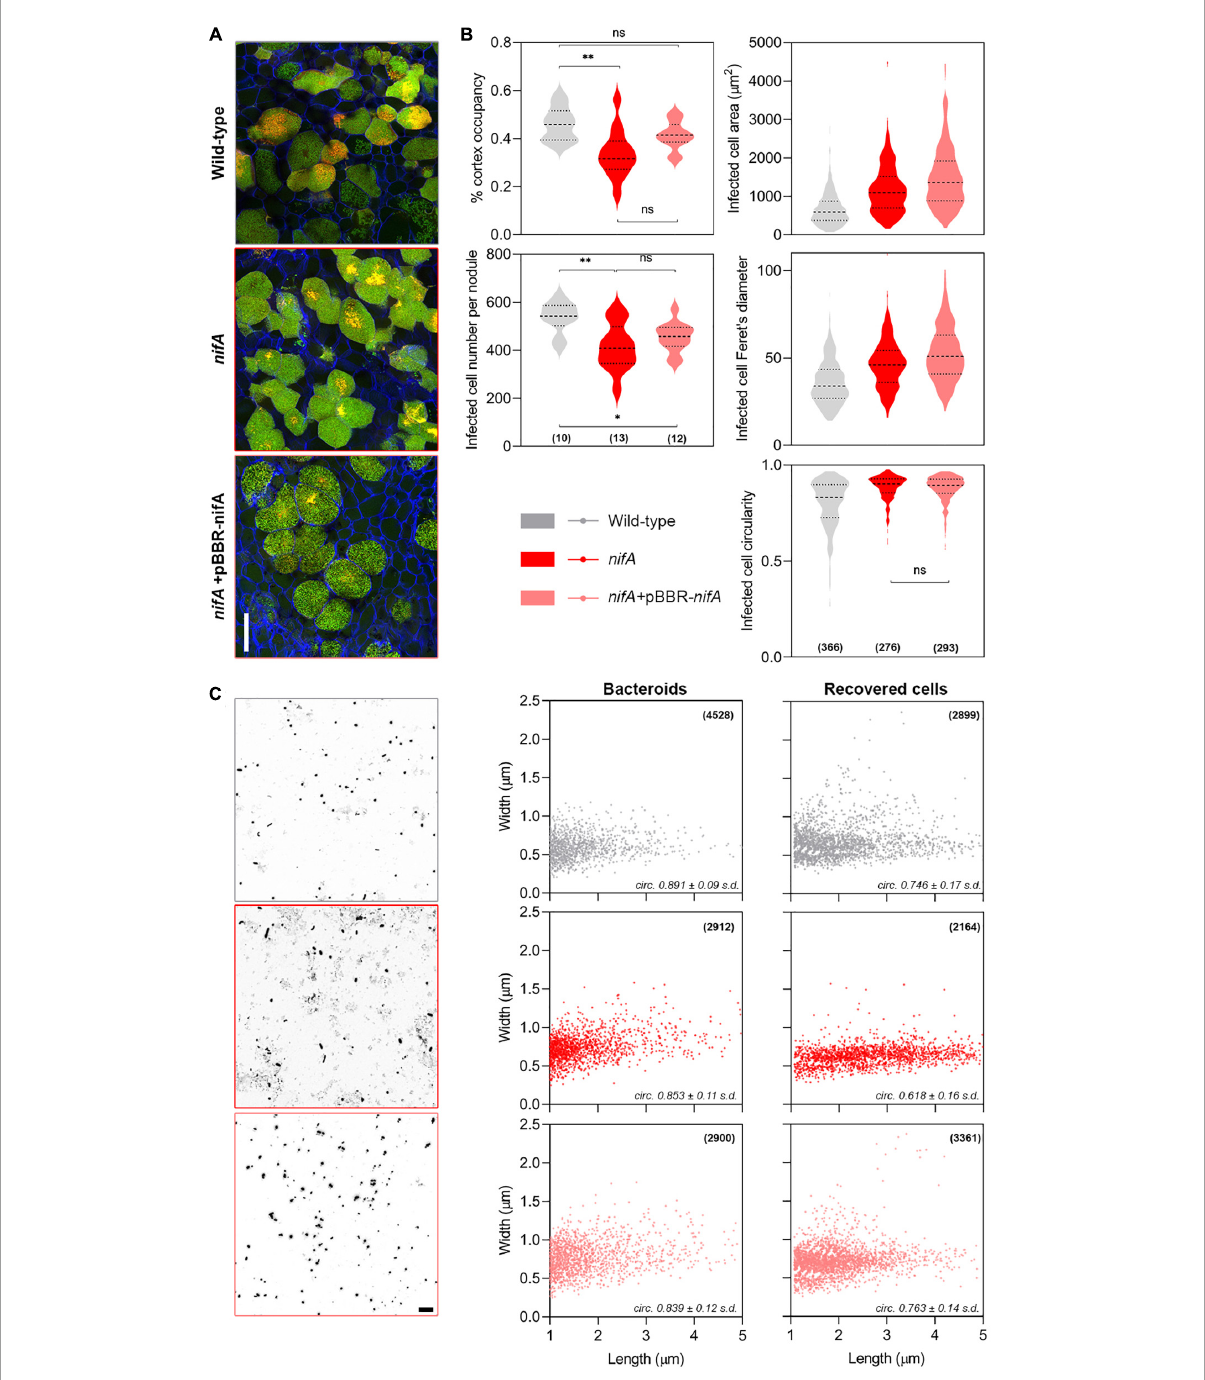
FIGURE2 Phenotypic characterization of Phaseolus vulgaris nodules occupied by Paraburkholderia phymatum wild-type, nifA and nifA -complemented strains. (A) Live/Dead staining of infected cells. Confocal laser scanning micrographs of nodular transversal sections. Maximum z-projections of 10 µ m × 0.5 µ m optical sections. Propidium iodide (red), Syto9 (green), and Calcofluor White (blue). Note the similar distribution of red/green signals between the different samples. All samples are shown at the same magnification, bar = 50 µ m. (B) Nodules and plant cells parameters. Numbers in brackets indicate the number of independent samples. Data represent two independent assays. Ordinary one-way ANOVA with Tukey’s post hoc test. The absence of annotation between samples implies p < 0.001. Otherwise ∗∗ p < 0.01, ∗ p < 0.05, ns, not significant. (C) Bacterial cells parameters. Left, high-contrast bright field micrographs of bacteroids preparations obtained from crushed fresh nodules. Bar = 10 µ m. Right, cytometric properties of bacteroids obtained from crushed nodules and bacteroids cultured in selective medium. Cell dimensions were extracted from CLSM micrographs with MicrobeJ. Numbers in brackets indicate sampled cells number. The calculated cell circularity is indicated in italics. s.d., standard deviation of